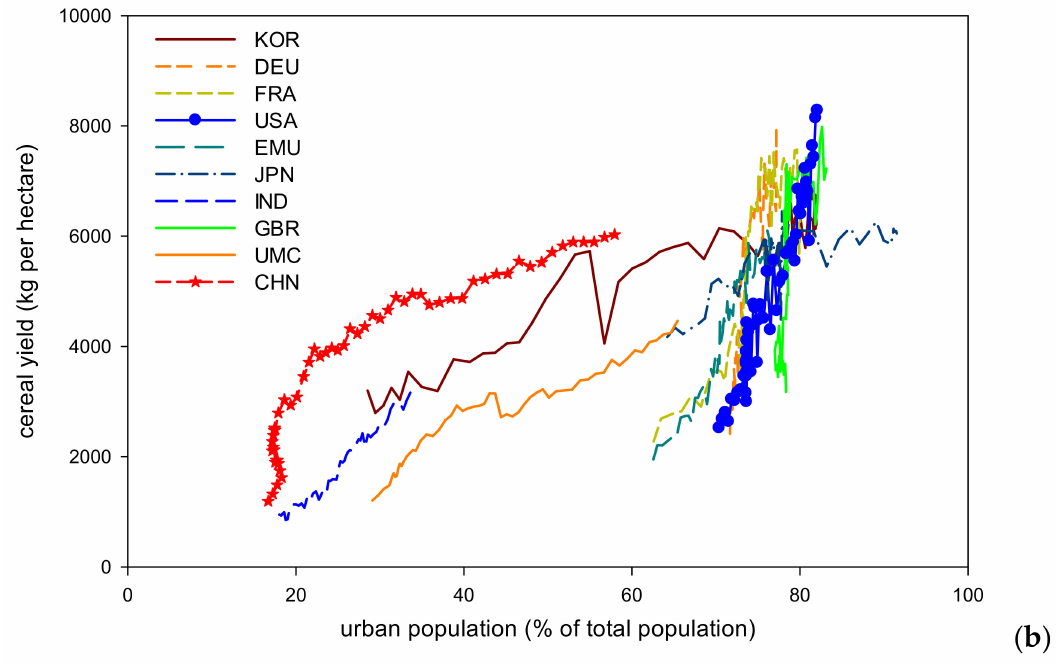
Figure 3. International comparison of cereal yield ( a ) and the relationship between cereal yield and urbanization rate ( b ) (1961–2017). Notes: KOR: Korea, Rep.; DEU: Germany; FRA: France; USA: United States; EMU: Euro area; JPN: Japan; IND: India; GBR: United Kingdom; UMC: Upper middle income; CHN: China. Data are collected from the World Bank